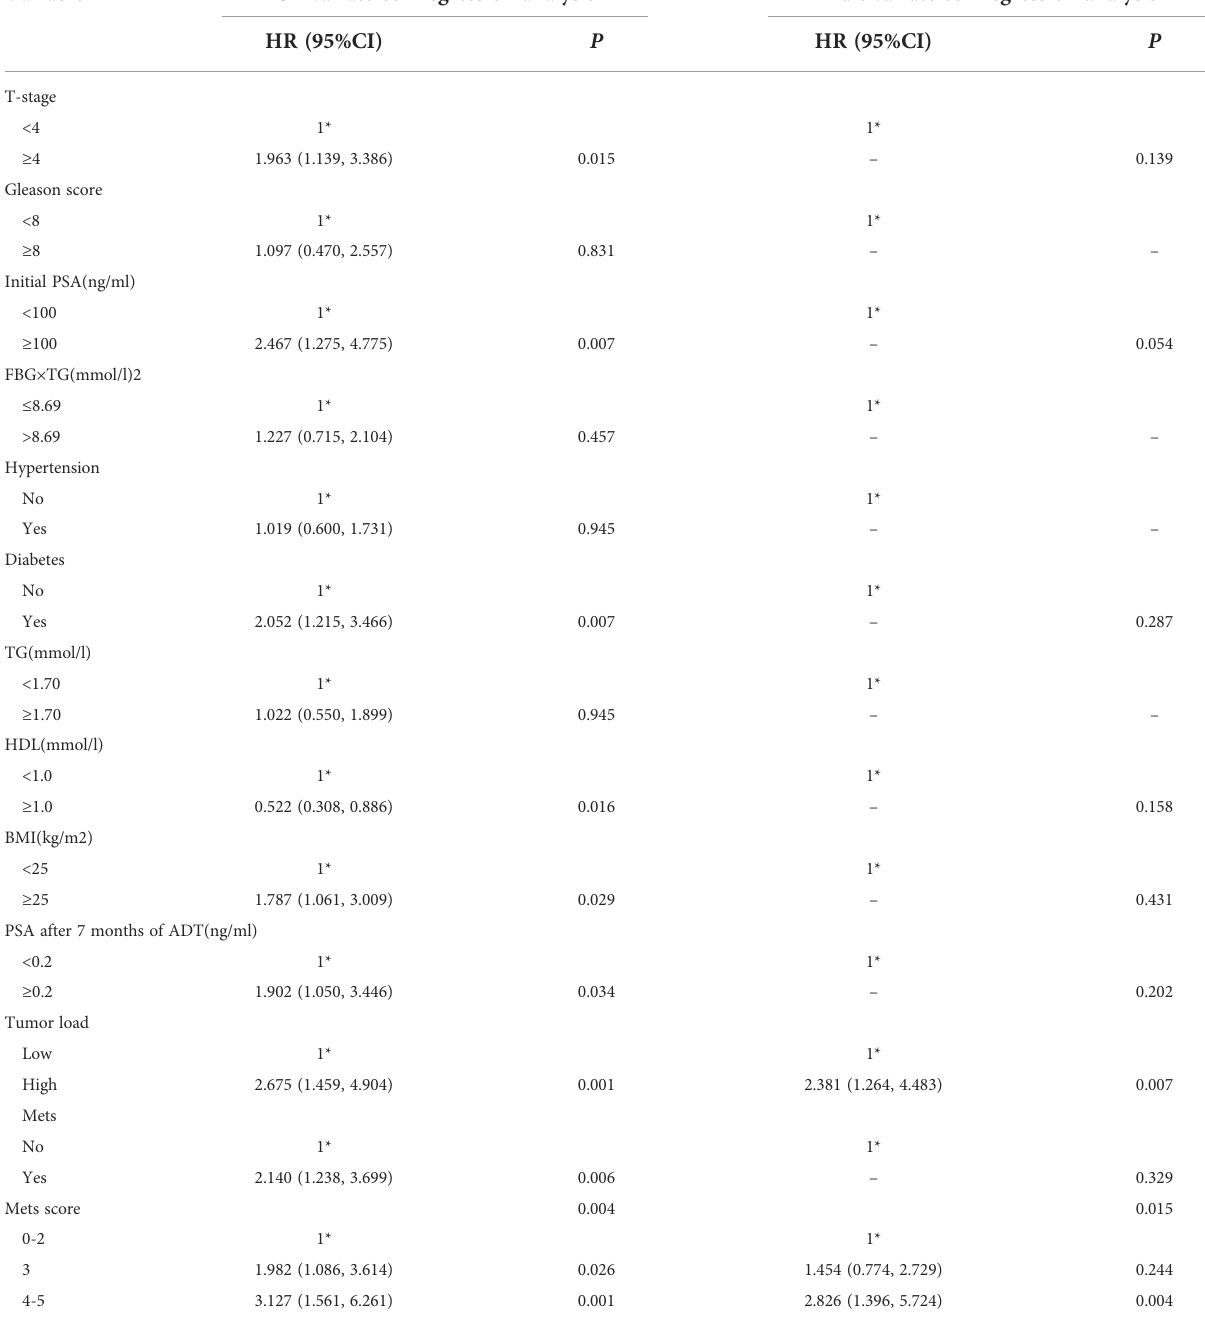
TABLE 6 Univariate analysis and multi-factor cox regression analysis.